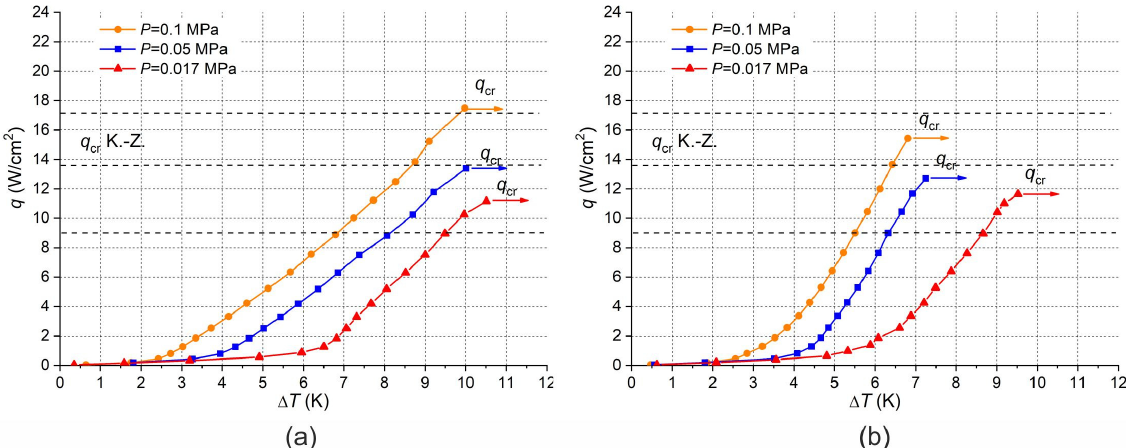
Figure 4. Boiling curves for the modified heaters at different pressures: ( a ) sample No. 1; ( b ) sample No. 2.